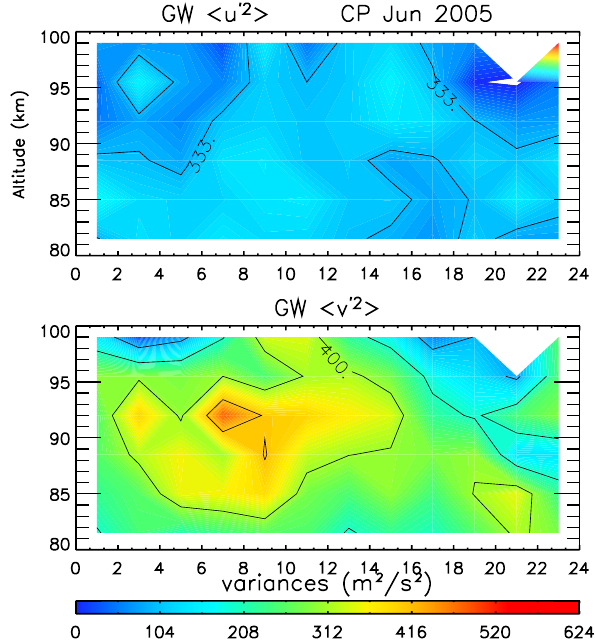
Fig. 22. The same as Fig. 21, but for June